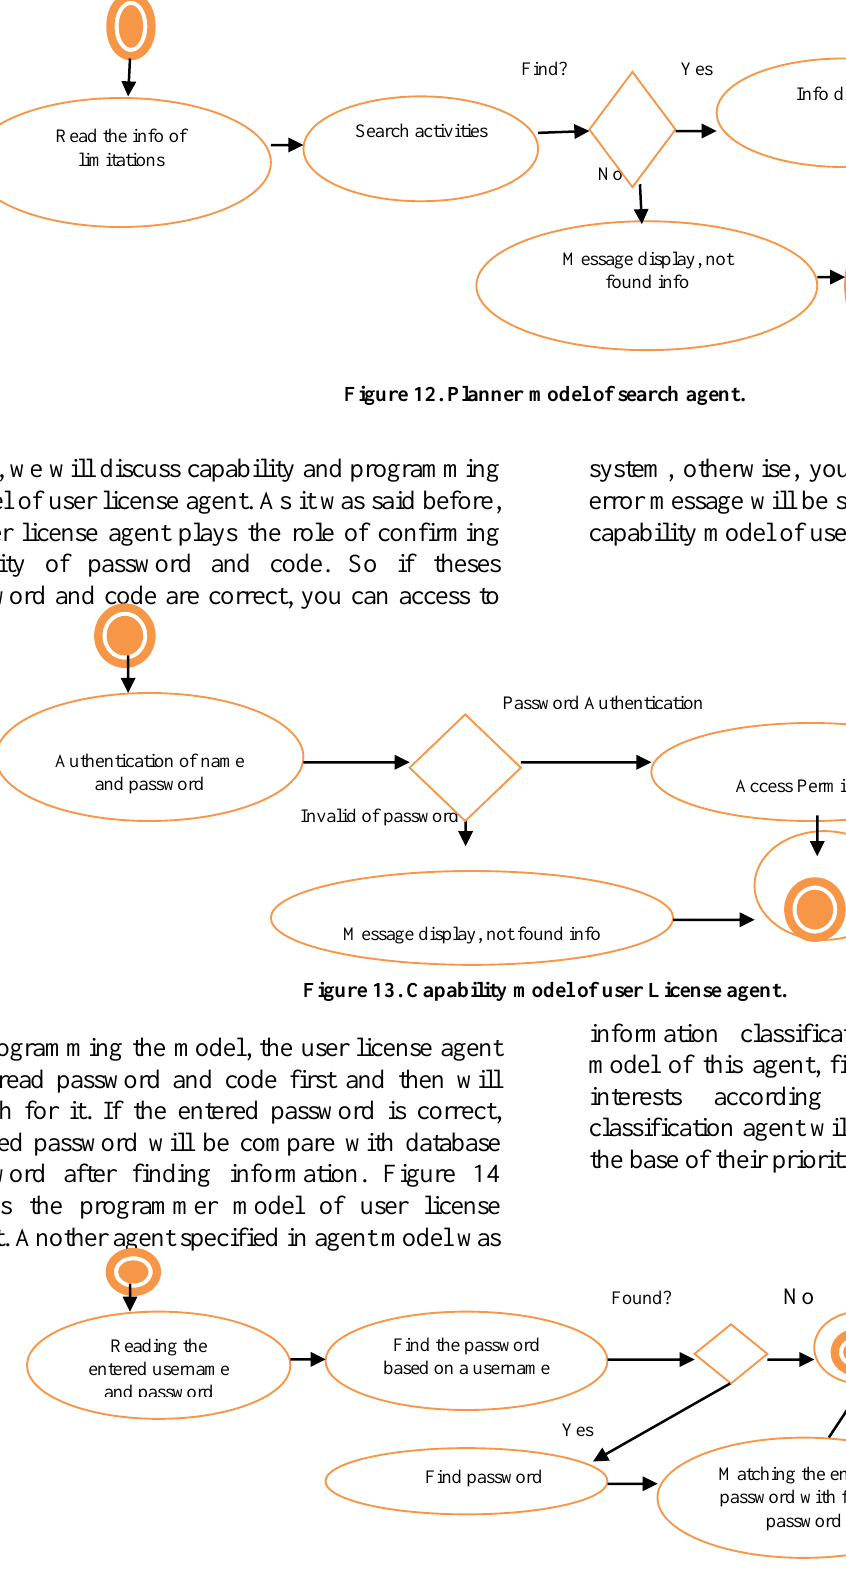
Figure 14. Planner model of user licenses